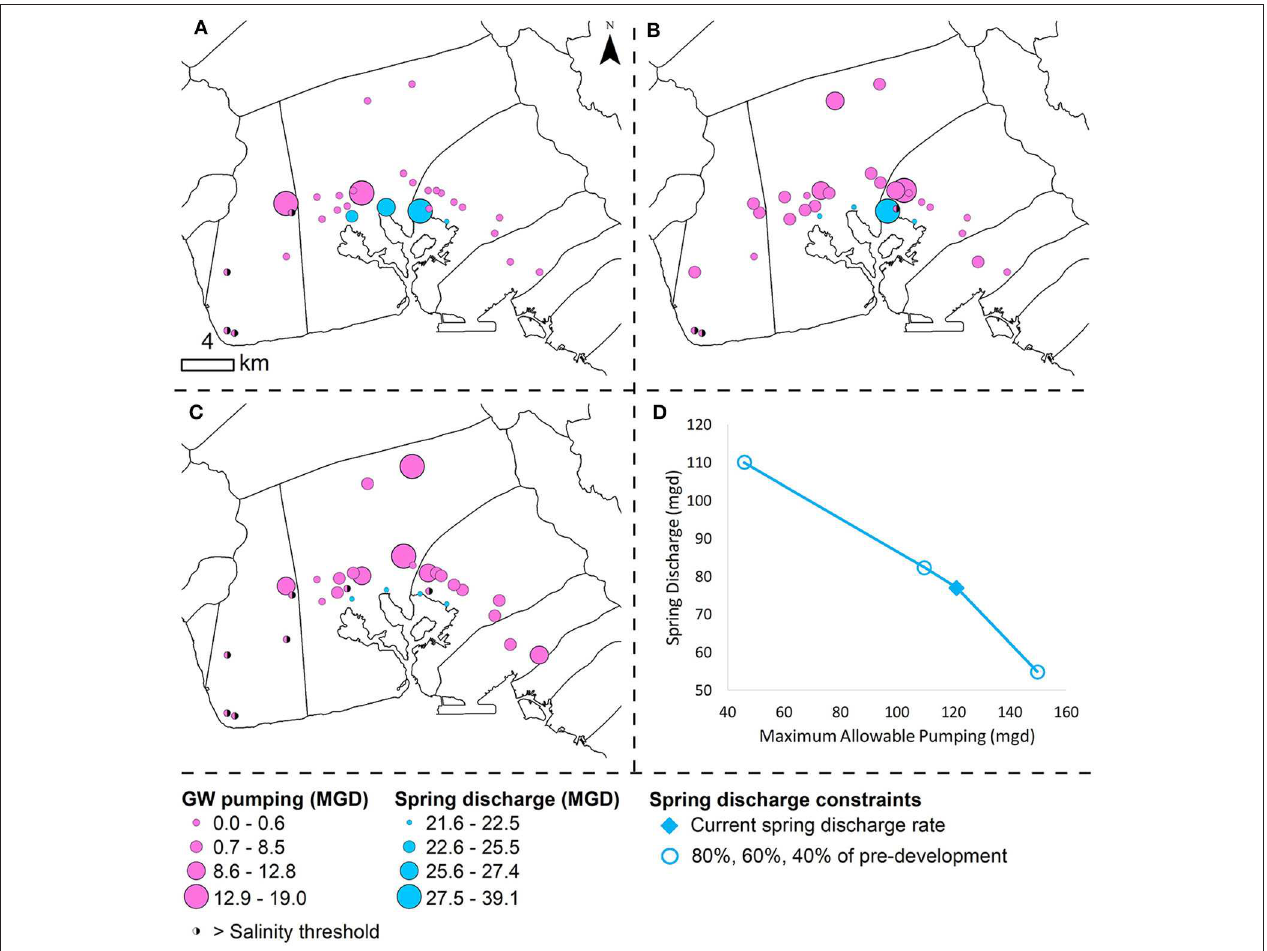
FIGURE 7 | Simulation optimization results with spring discharge constrained at: (A) 80%, (B) 60%, (C) 40%. (D) Estimated spring discharge-SY tradeoff curve. Current pumping within the Pearl Harbor aquifer (117 MGD) allows for approximately 77 MGD of total spring discharge (marked with a diamond) given optimum